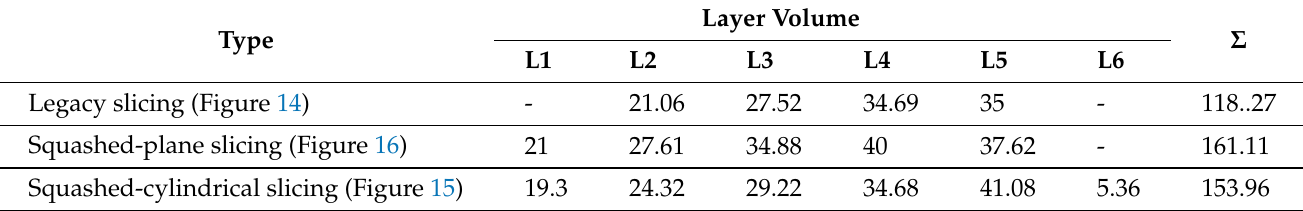
Table 4. Comparison of Slicing